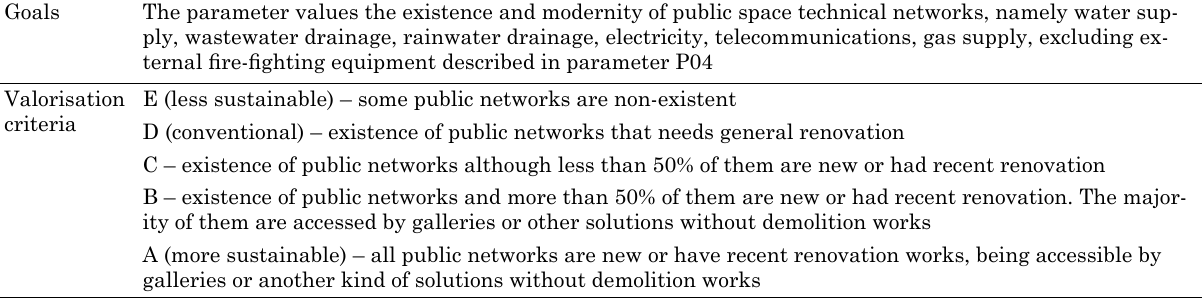
Table 3. Thematic description and valorisation criteria of the parameter P05 – Technical networks in public space goals The parameter values the existence and modernity of public space technical networks, namely water sup - ply, wastewater drainage, rainwater drainage, electricity, telecommunications, gas supply, excluding ex - ternal fire-fighting equipment described in parameter P04 Valorisation criteria